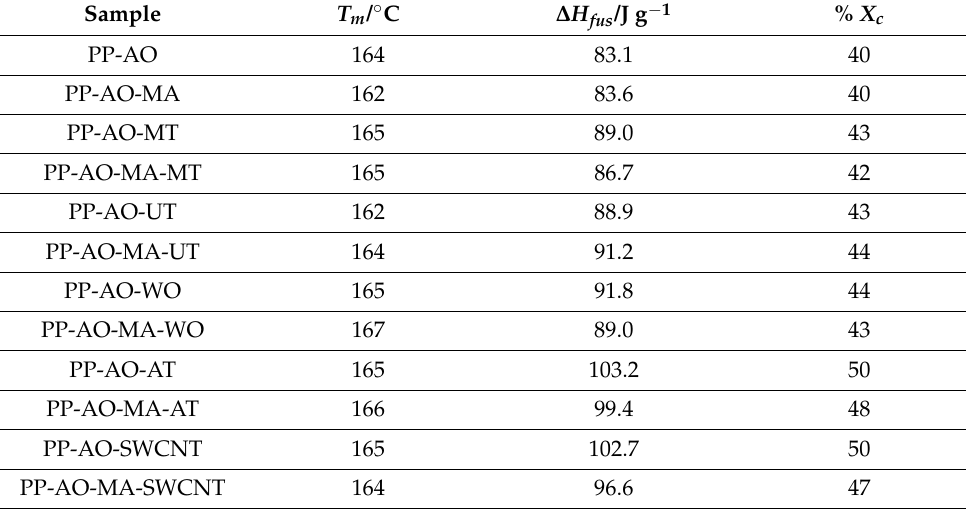
Table 4. Results from DSC